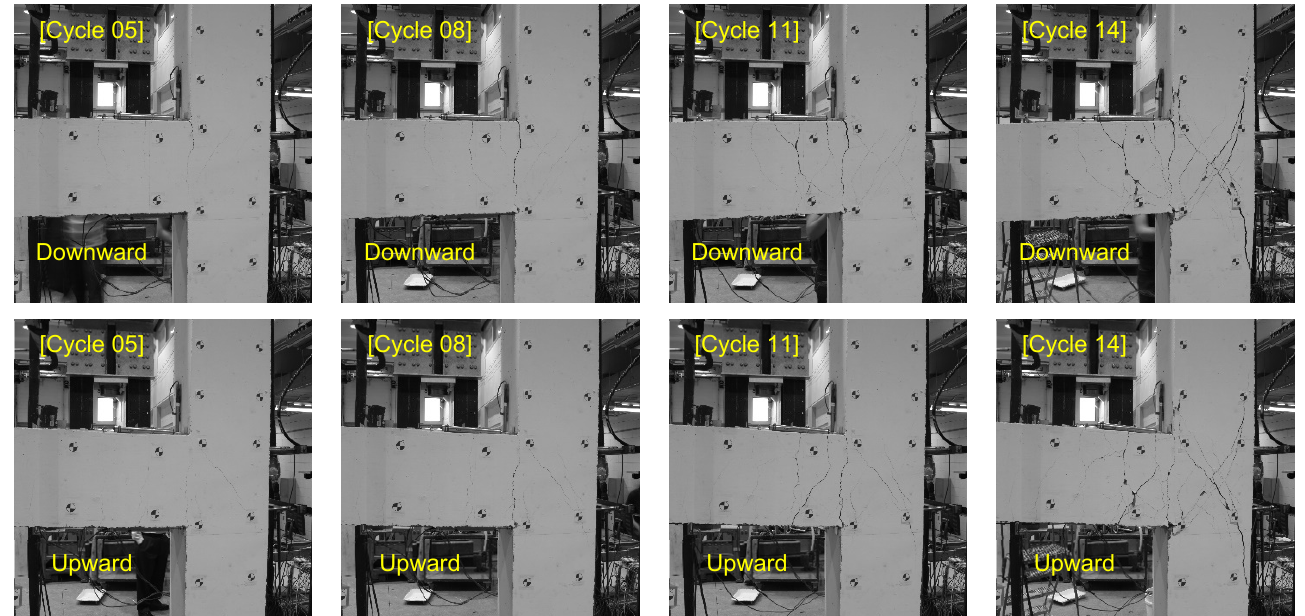
Figure 1. Examples of images of beam-column joint in a cyclic loading test used in a target dataset.